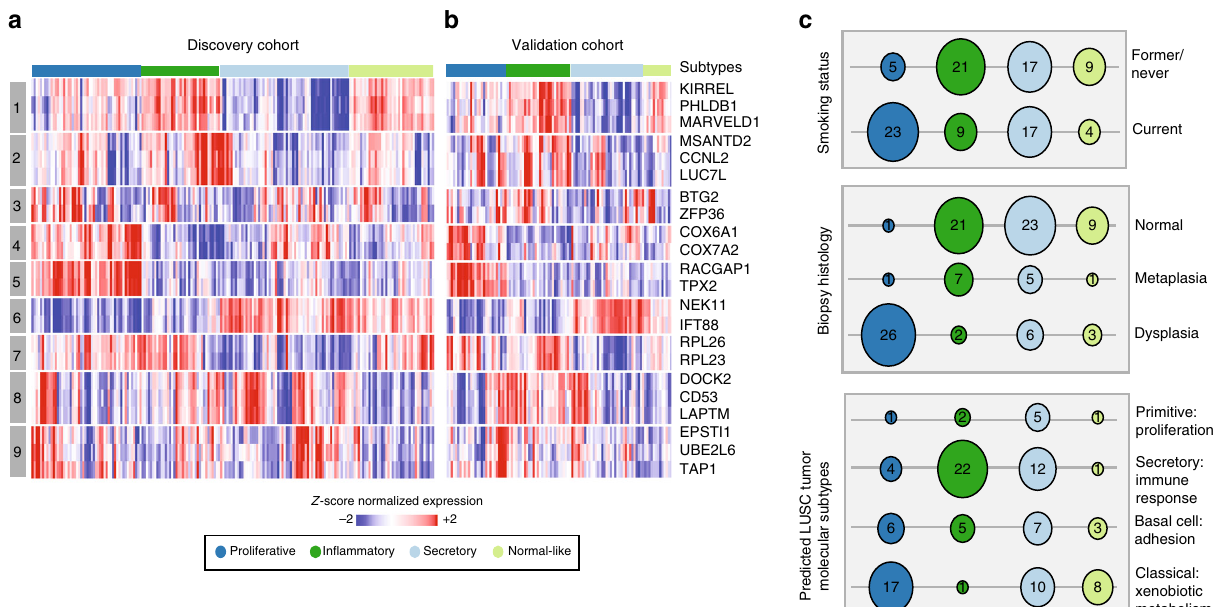
Fig. 2 Phenotypic associations with the molecular subtypes are con fi rmed in an independent sample set. a The 190 DC biopsies and the 3936 genes were used to build a 22-gene nearest centroid molecular subtype classi fi er. The heatmap shows semi-supervised hierarchal clustering of z-score normalized gene expression across the 22 classi fi er genes and 190 DC biopsies training samples. b The 22-gene nearest centroid molecular subtype classi fi er was used to predict the molecular subtypes of the 105 VC biopsies. The heatmap shows semi-supervised hierarchal clustering of z-score normalized gene expression across 22 genes and 105 VC. The rows of the heatmap give the gene name and module membership, and the column color bar shows molecular subtype membership. c Bubbleplots showing signi fi cant associations ( p < 0.01 by two-sided Fisher ’ s exact test) between the VC molecular subtypes and smoking status, biopsy histological grade, and the predicted LUSC tumor molecular subtypes. The columns represent the four molecular subtypes (Proliferative, In fl ammatory, Secretory, and Normal-like) and the radius of the circle is proportional to the number of samples within each subtype that have the row phenotype. Source data are provided as a Source Data fi